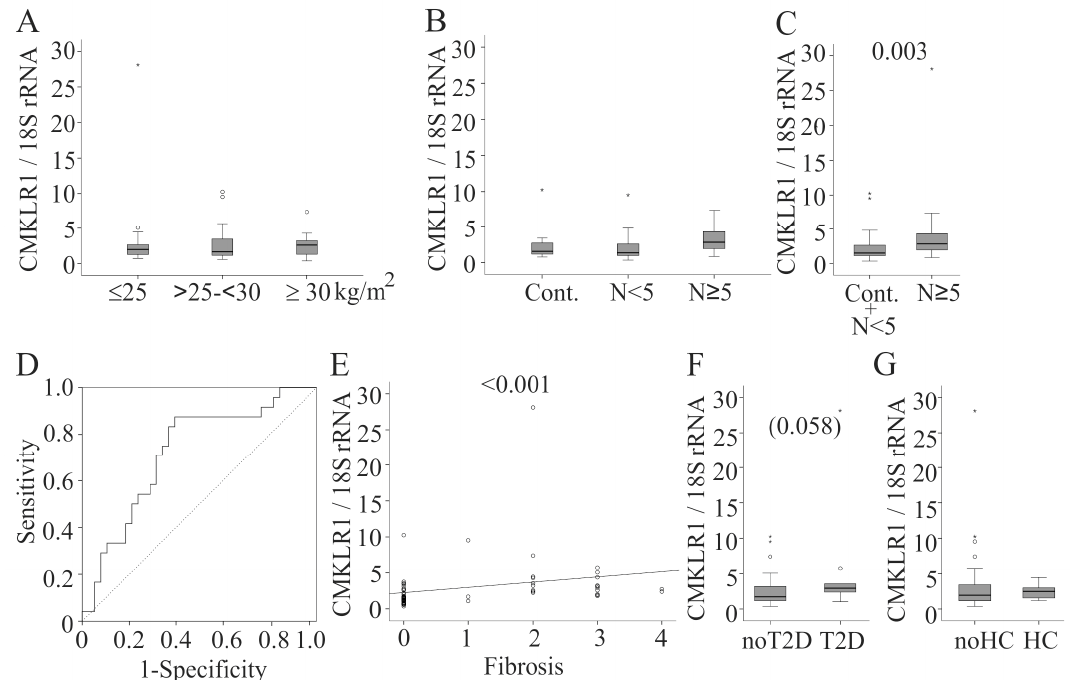
Figure 4. CMKLR1 mRNA (normalized for 18S rRNA) in male NAFLD patients. ( A ) CMKLR1 mRNA in the liver of normal-weight (BMI ≤ 25 kg/m 2 ), overweight (BMI > 25 and < 30 kg/m 2 ) and obese (BMI ≥ 30 kg/m 2 ) male patients; ( B ) CMKLR1 mRNA in liver tissues of male patients with healthy liver (Cont.), a NASH score ( N ) <5 and ≥ 5; ( C ) CMKLR1 in male controls and borderline NASH compared to male NASH patients; ( D ) ROC analysis; ( E ) Correlation of hepatic CMKLR1 mRNA in males with fibrosis; ( F ) Hepatic CMKLR1 mRNA in males with and without type 2 diabetes (T2D); ( G ) Hepatic CMKLR1 in males with and without hypercholesterolemia. The p -values for significant differences are shown in the figure. Numbers in brackets indicate a